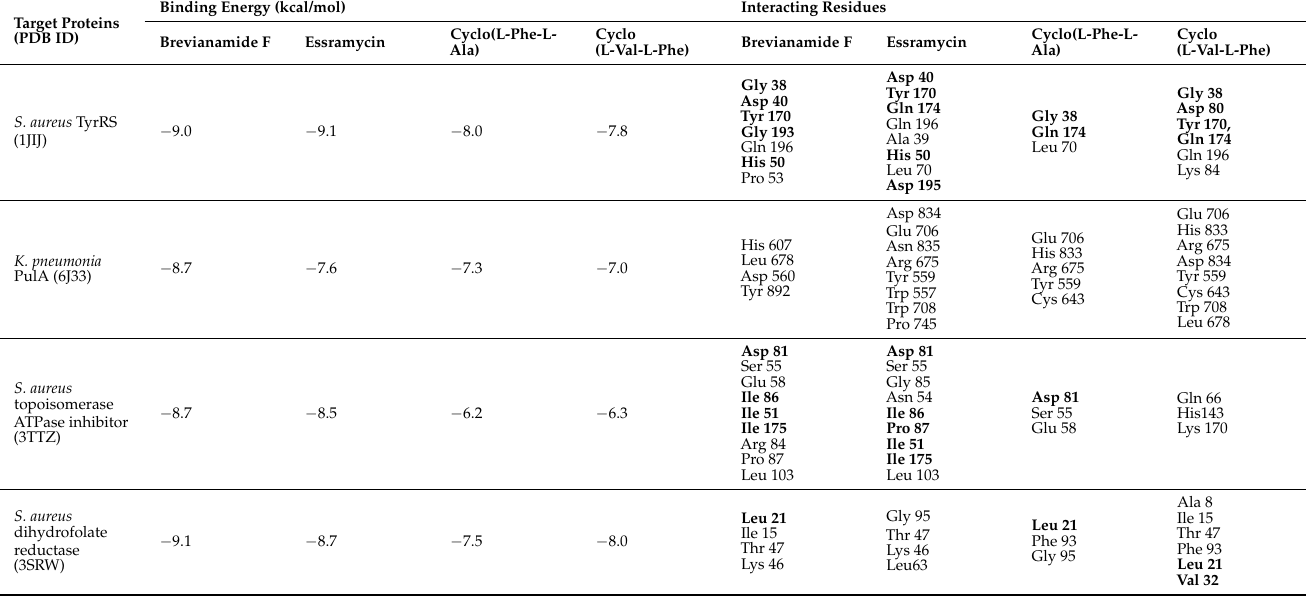
Table 5. The binding energies and interacting residues (important residues are represented in bold) of target proteins with potent